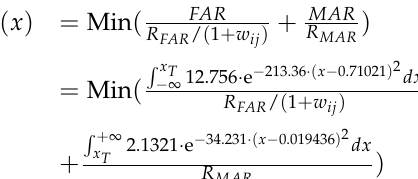
cluding weight w 1 = 0.453, Equations (1) and (2), R FAR = R MAR = 0.01 are inputted